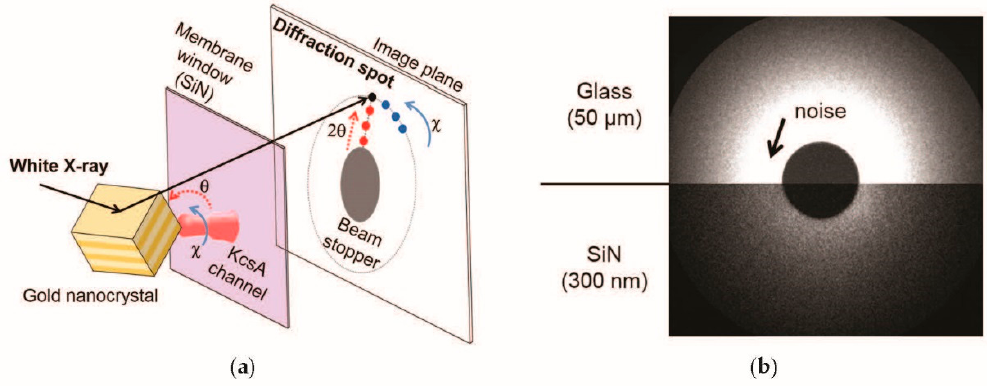
Figure 1. ( a ) Principle of the DXT method. White X-rays are diffracted by the gold nanocrystal; ( b ) Background noise recorded under the same X-rays irradiation